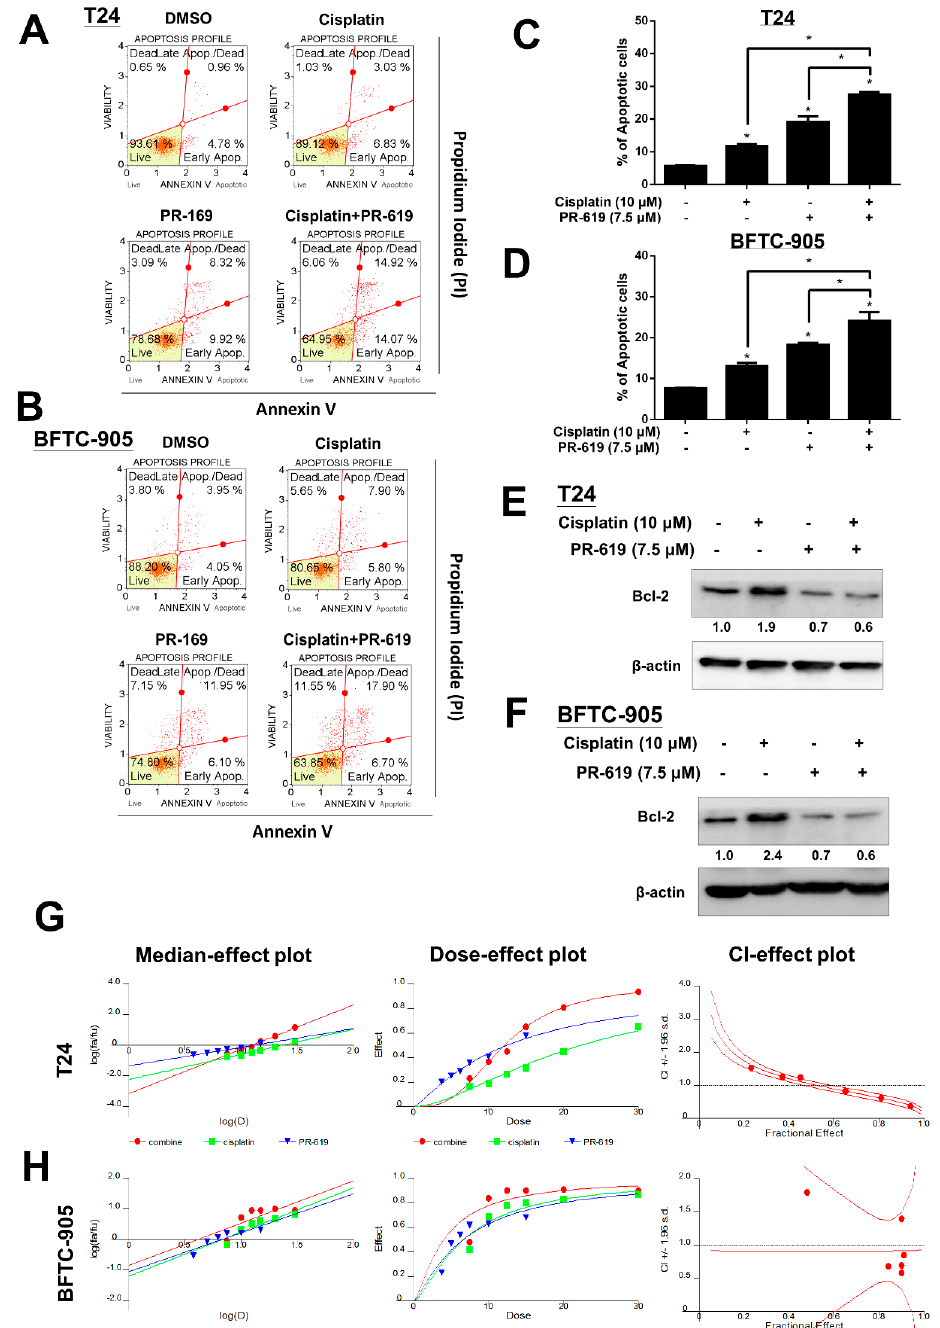
Figure 4. PR-619 enhanced cisplatin-induced cytotoxicity in human UC cells. ( A ) T24 and ( B ) BFTC-905 were treated with PR-619 (7.5 µ M), cisplatin (15 µ M), or a combination for 24 h. Apoptotic cells